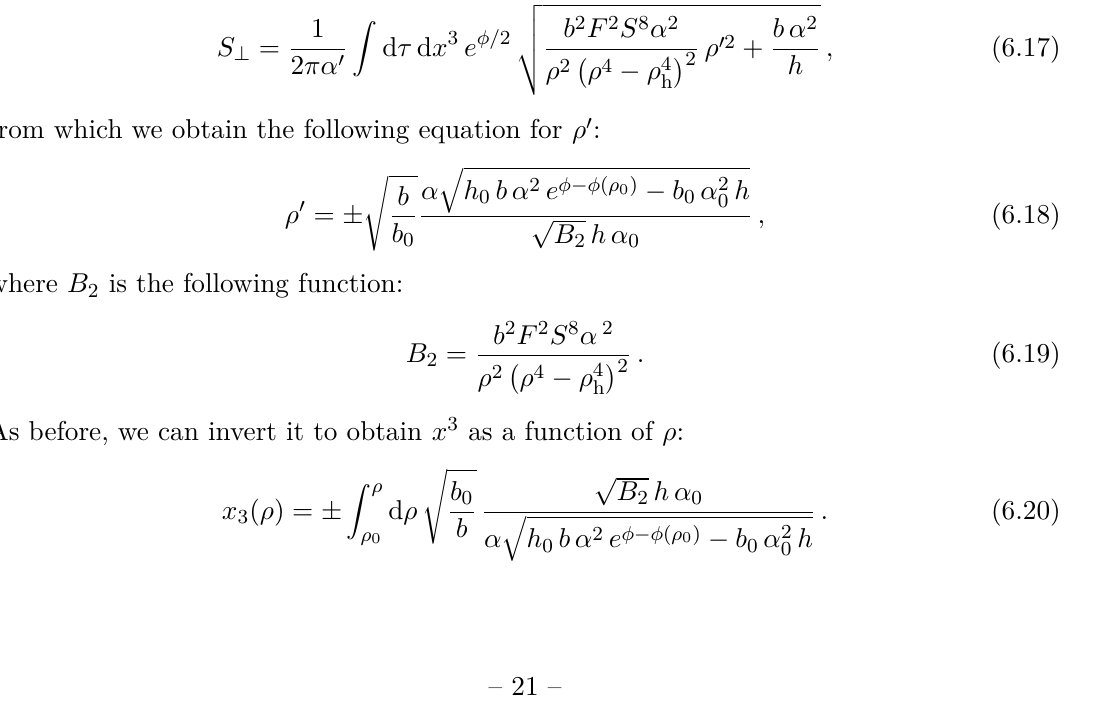
Figure 3 . Comparison between the corrections at different orders. In these plots ˜ V a = Vol( M 5 ) and ˜ d a = π T d a for a = k , ⊥ and ˜ ρ 0 = ρ 0 /ρ h